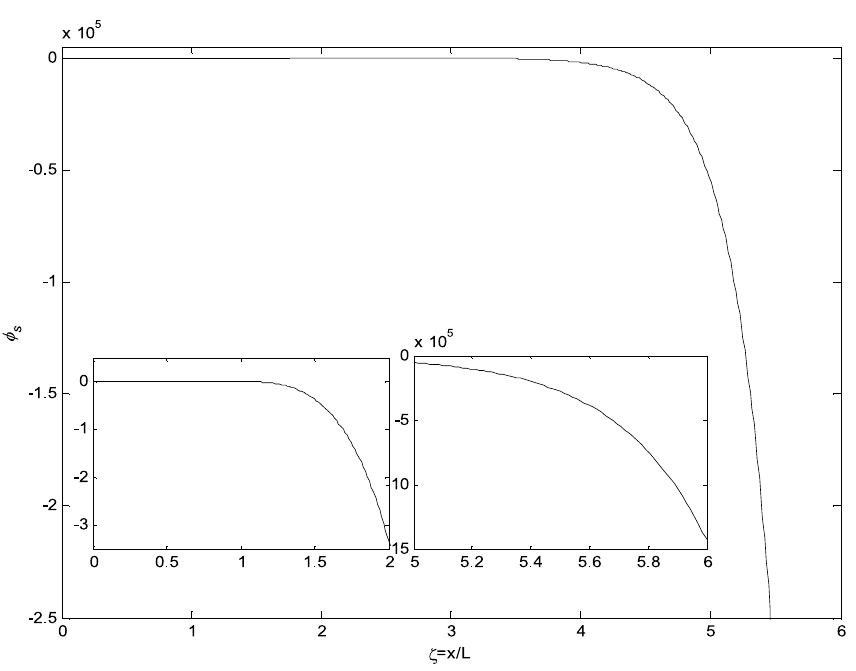
Fig. 8. Particular part of the second mode shape for the six-span